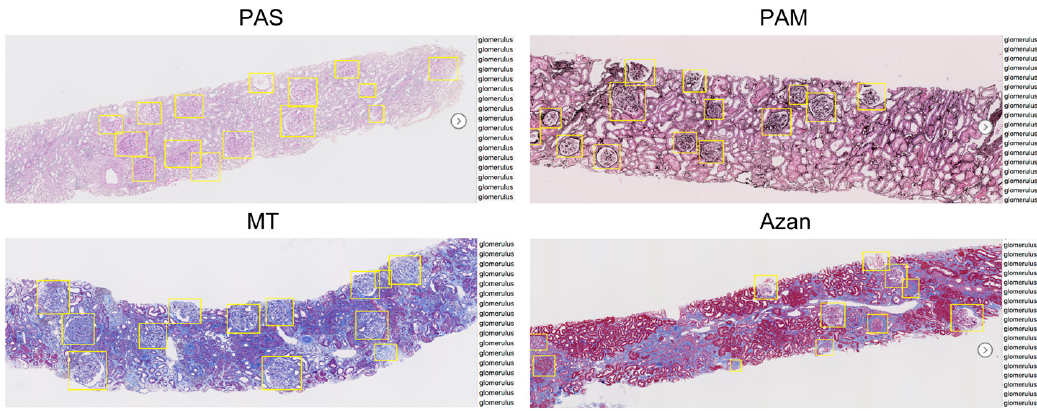
Figure 1. Examples of annotation with different stains using the RectLabel tool. PAS, periodic acid-Schiff; PAM, periodic acid-methenamine silver; MT, Masson trichrome. Table 2. Summary of datasets.